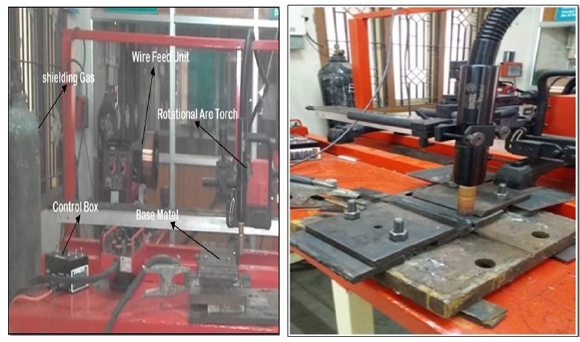
Figure 1: Rotational arc welding machine set